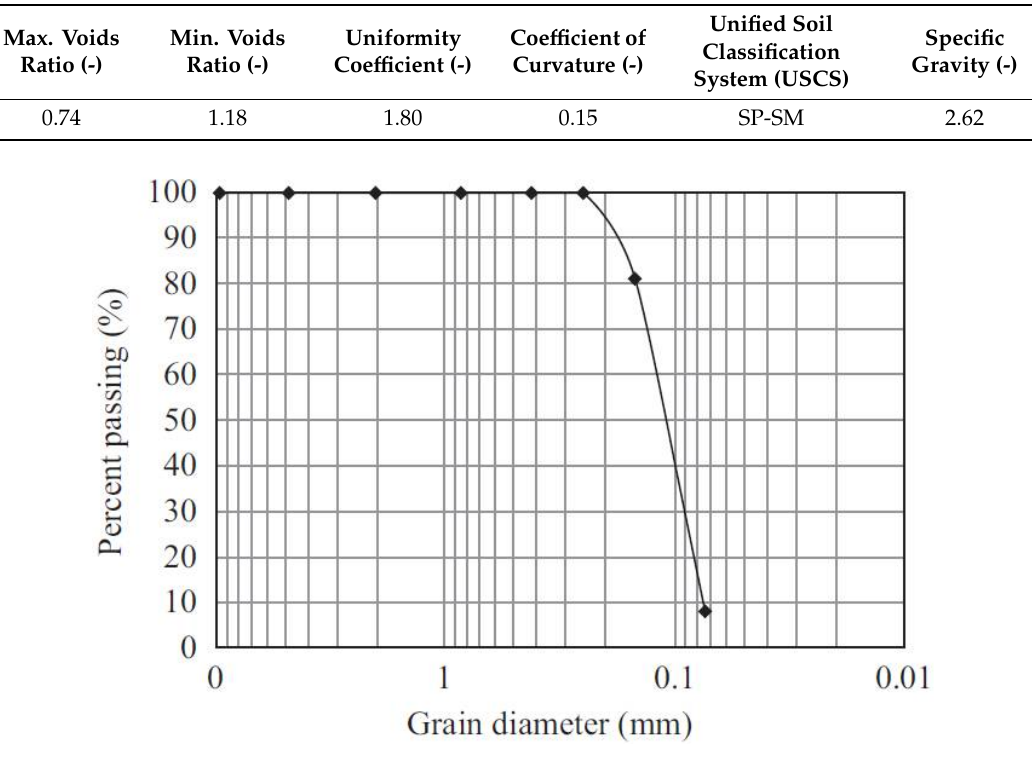
( b ) Figure 6. Effective internal friction angle (adapted from [21]): ( a ) Dr = 50%; ( b ) Dr = 85%. y = 0.574x 020 40 6080100 120 140 160 180200 0